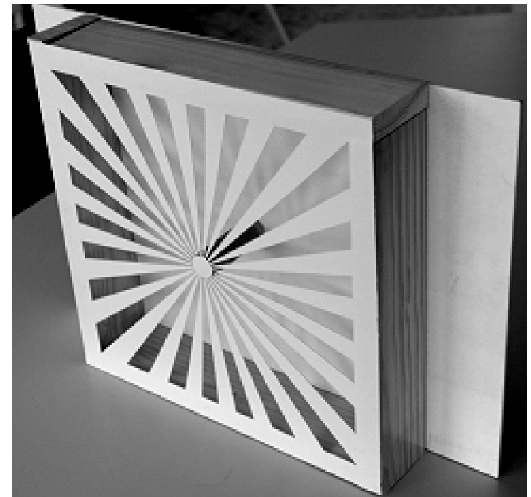
Figure 8. Boehler Star used to measure the spatial resolution of laser scanners (Boehler, et al., 2003) Figure 8 shows the so-called Boehler Star, which is a three- dimensional form of the Star Siemens for determining the spatial resolution laser scanner sensors. If the tested sensor has a high resolution, the resulting point cloud should consist not only of points on the front wall of the target, but also include points on the back wall of the target. The better the resolution of the tested sensor, the more points on the back wall will be visible close to the centre of the. (Boehler, et al.,